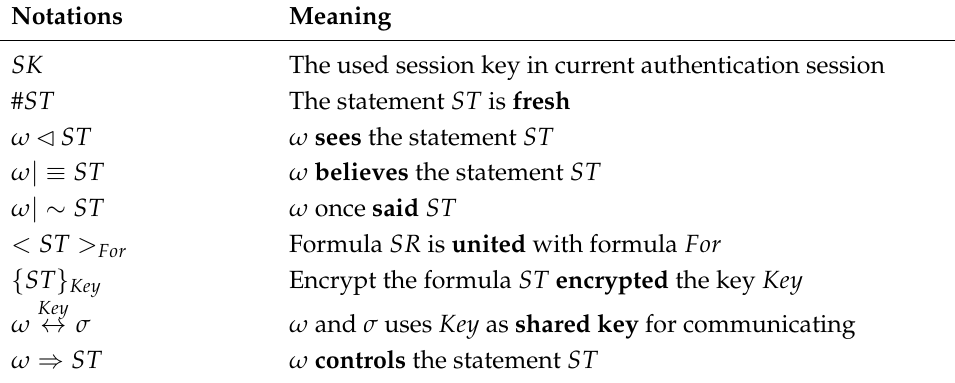
Table 2. The basic BAN logic